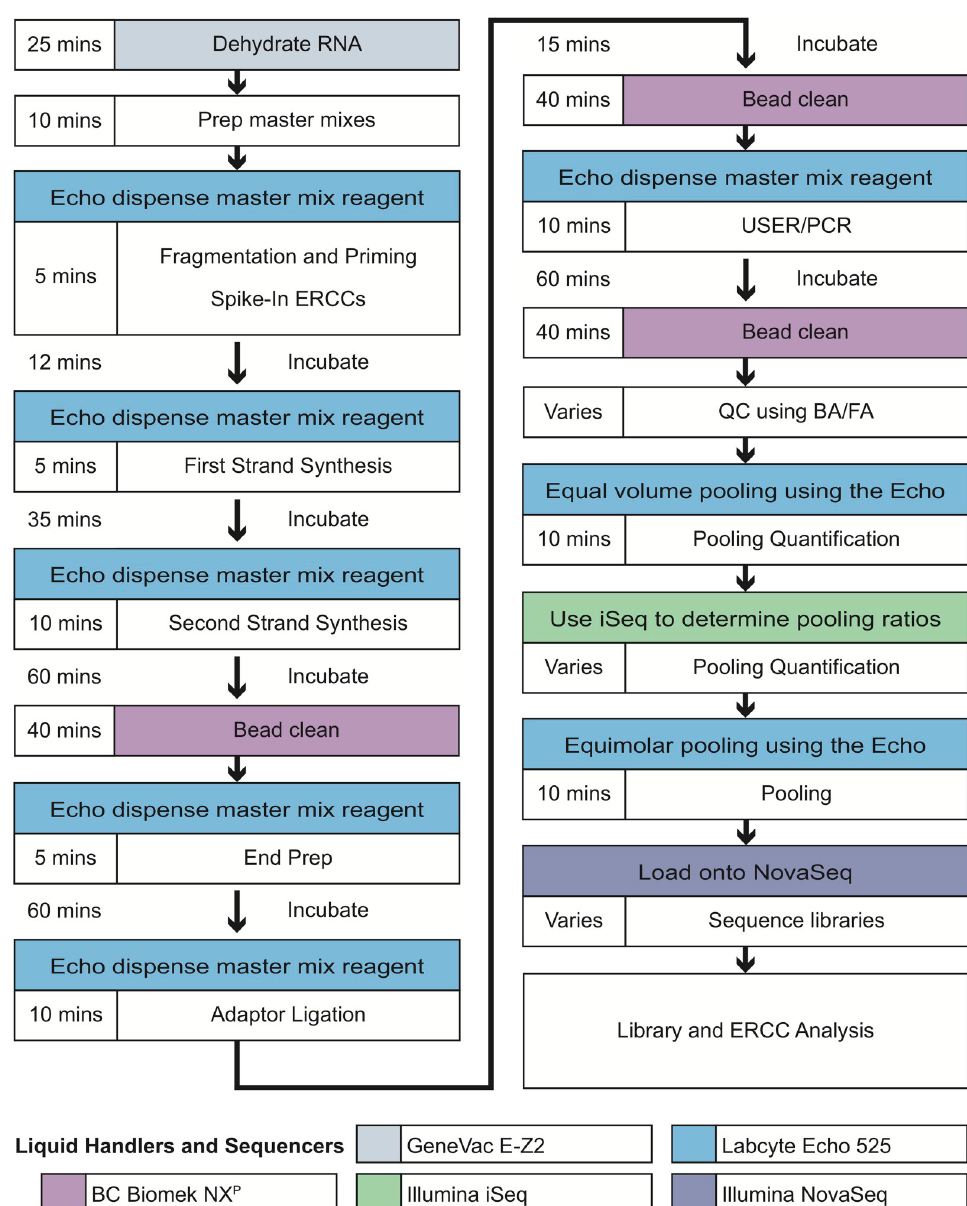
Fig 1. Overall workflow. Workflow of the miniaturized, automated library preparation protocol. The complete protocol is available https://www.protocols.io/private/07DC2C6765A0D9665C227879D935EED3.